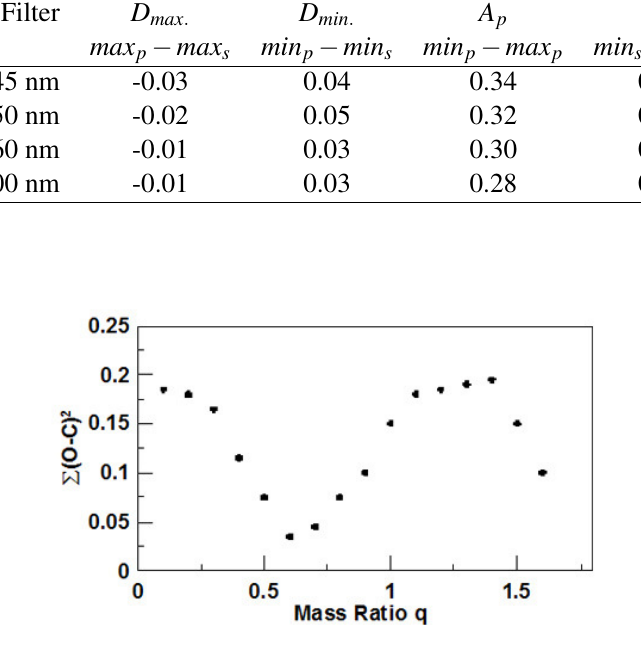
Fig. 4 Relation between ∑ and q .